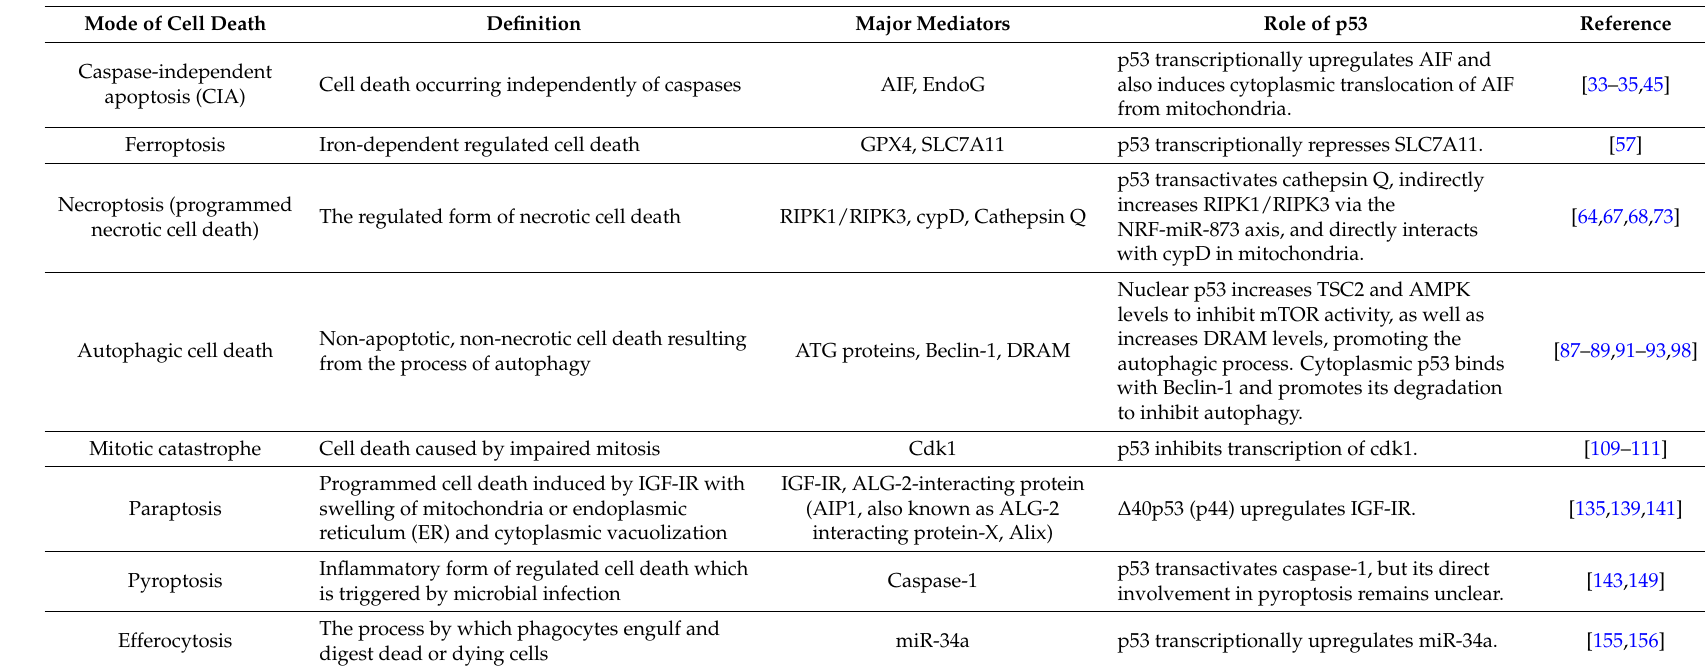
Table 1. p53 mediated non-canonical cell death